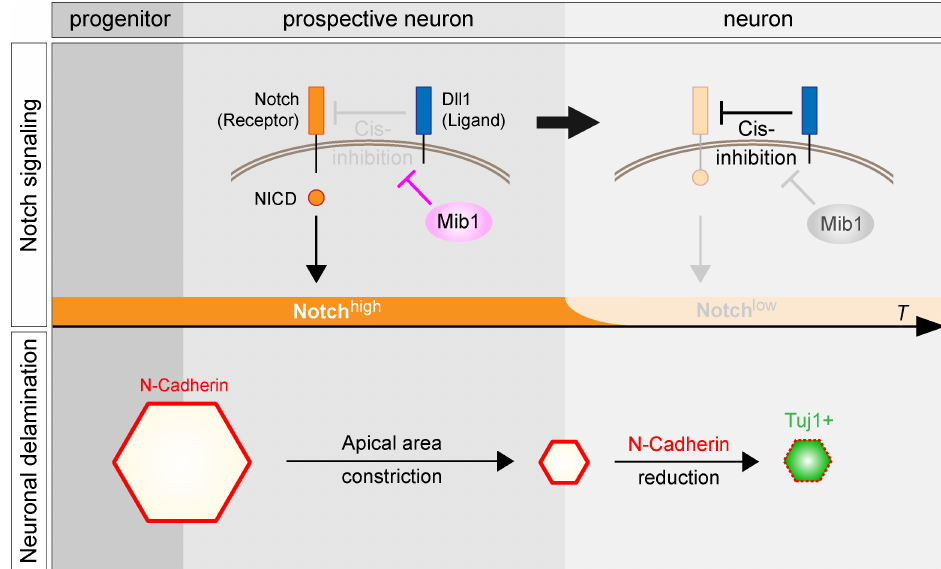
Fig 6. Model for the role of Mib1-dependent Notch activity in the regulation of neuronal delamination. Top: Prospective neurons maintain a high level of Notch activity until they fully differentiate. Mib1 is required during that transition phase to keep Dll1 from Cis -inhibiting the Notch receptor. This allows Notch to be Trans -activated by Dll1 present on neighboring cells (not represented here), resulting in the release of the NICD. When the Dll1/Mib1 ratio is sufficiently high, Cis -inhibition takes place and Notch activity is rapidly turned off. Bottom: Sustained Notch activity allows prospective neurons to shrink their apical area and keeps them from differentiating. As Notch activity is decreased, N-Cadherin levels are down-regulated and neuronal differentiation markers start being expressed. Dll1, Delta-like 1; Mib1, Mindbomb1; NICD, Notch intracellular domain; T , time.